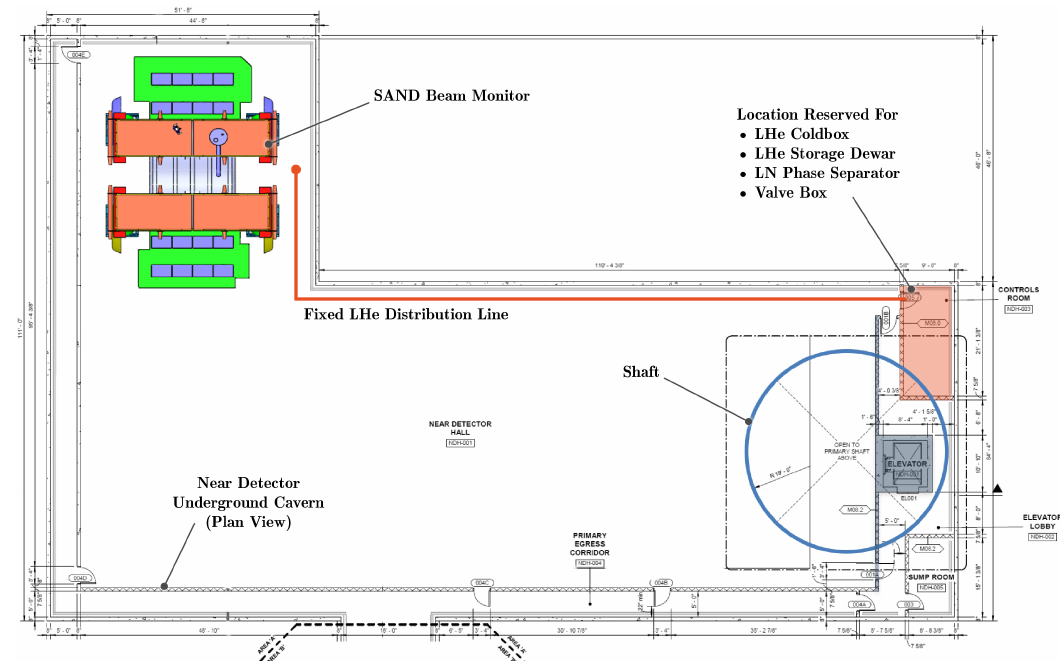
Figure 175. A small, commercially available cryoplant will be sufficient to cool the SAND superconducting solenoid. Its coldbox can be located underground in the vicinity of the shaft.